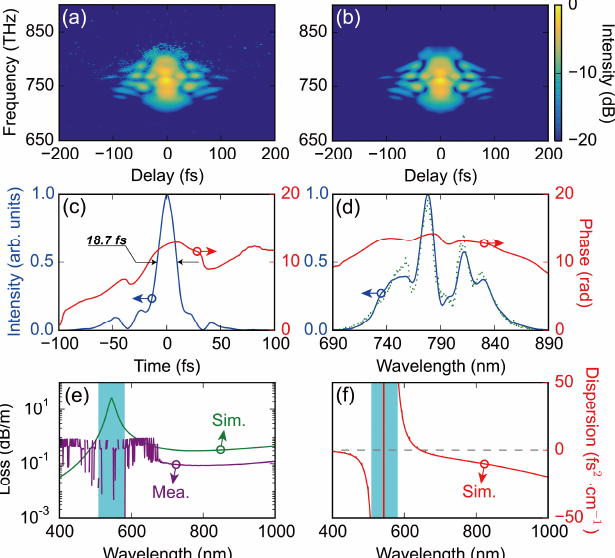
Figure 2. Plotted using the open source software Python(x,y). ( a , b ) Measured and retrieved SHG- FROG traces of the pulses in front of the focusing lens. ( c , d ) Retrieved temporal and spectral profiles (blue solid lines) and the corresponding phase (red solid lines). The green dotted line in panel ( d ) represents the measured reference spectrum. ( e ) Simulated (green solid line) and measured (purple solid line) fiber losses of the fundamental mode HE 11 of the SR HC-PCF. ( f ) Simulated dispersion (red solid line) of the SR HC-PCF filled with 1.4-bar Ar gas. The simulated fiber loss and dispersion are calculated through the BR and ZS models, respectively. In both ( e , f ), the cyan bars show the first resonant spectral region of the SR HC-PCF.